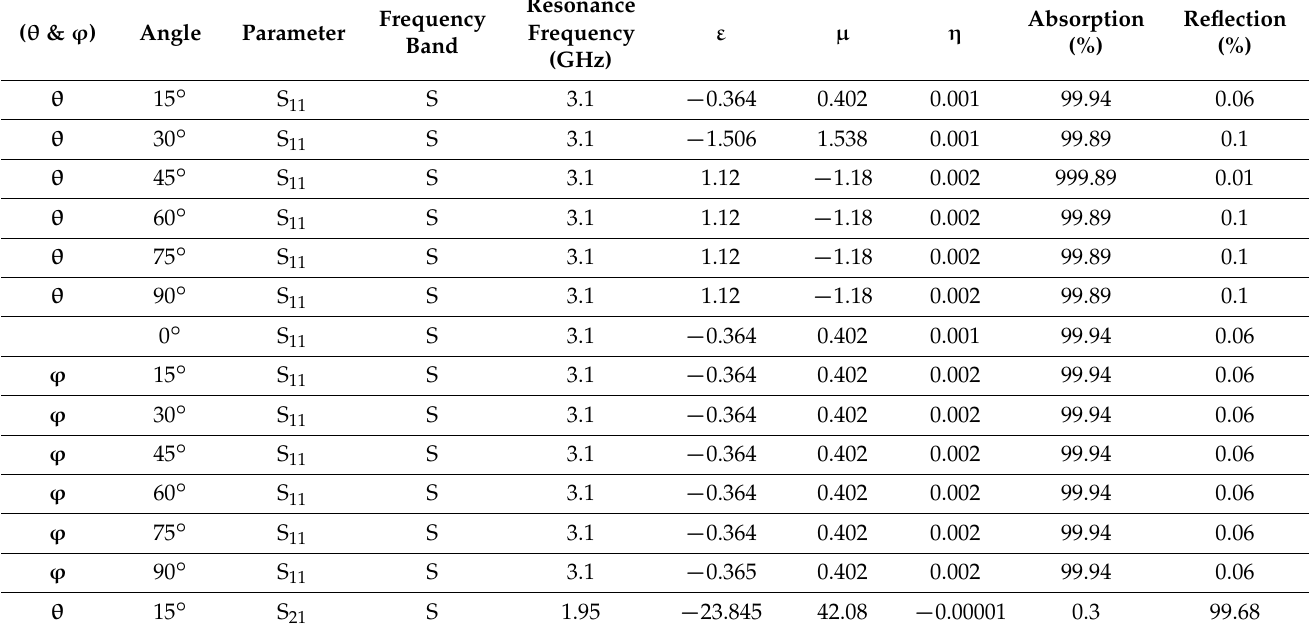
Table A1. Permittivity, permeability, and reflective index at S 11 and S 21 for FR4 substrate at different polarization angles of θ and ϕ